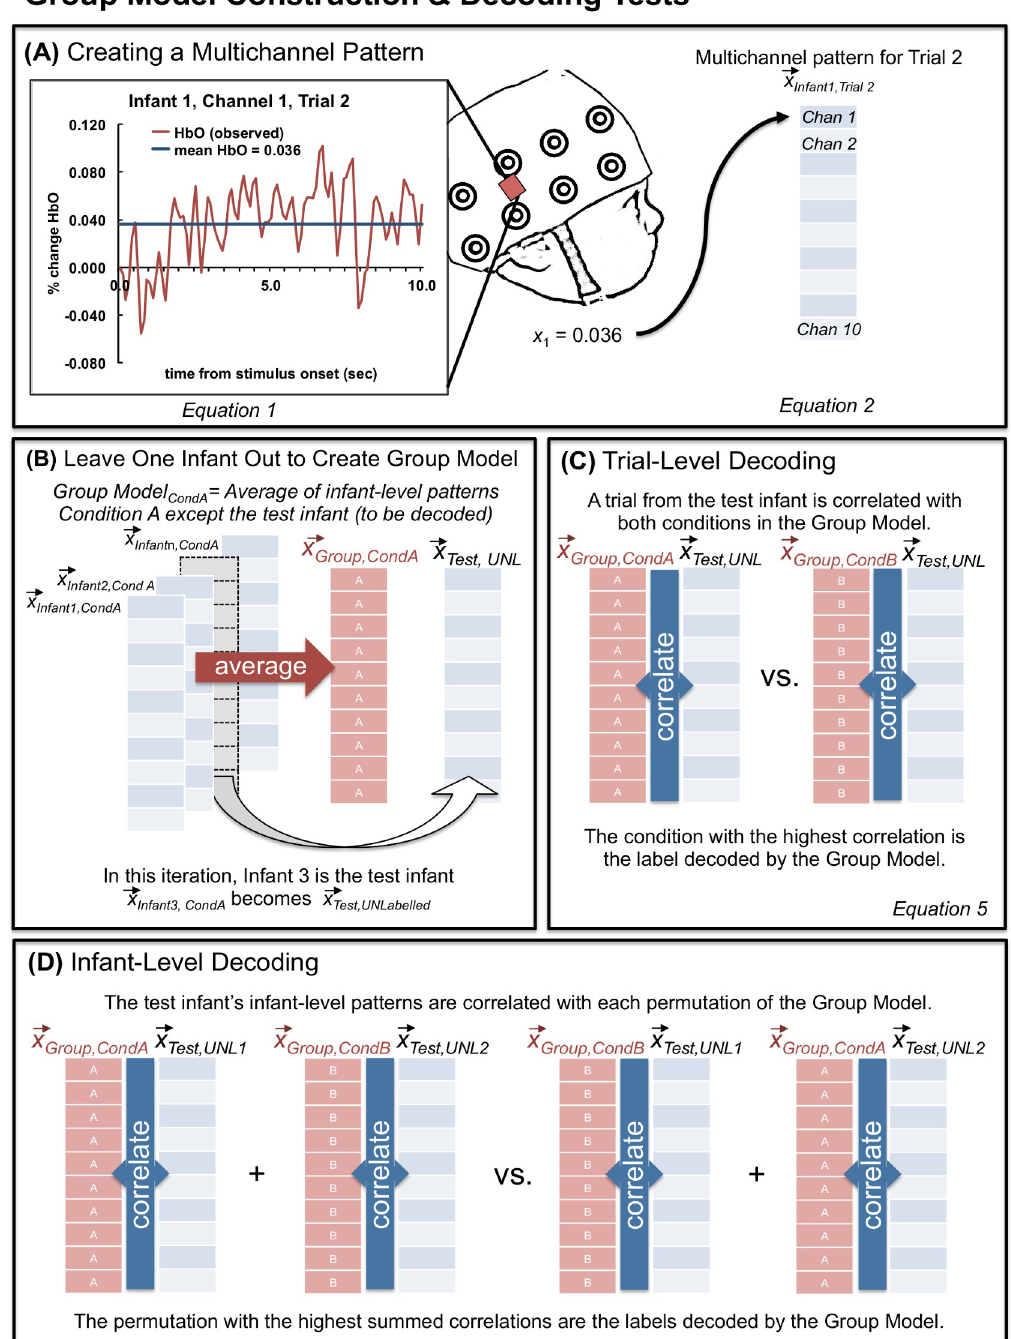
Fig 2. Illustration of the multivariate methods applied to fNIRS in this